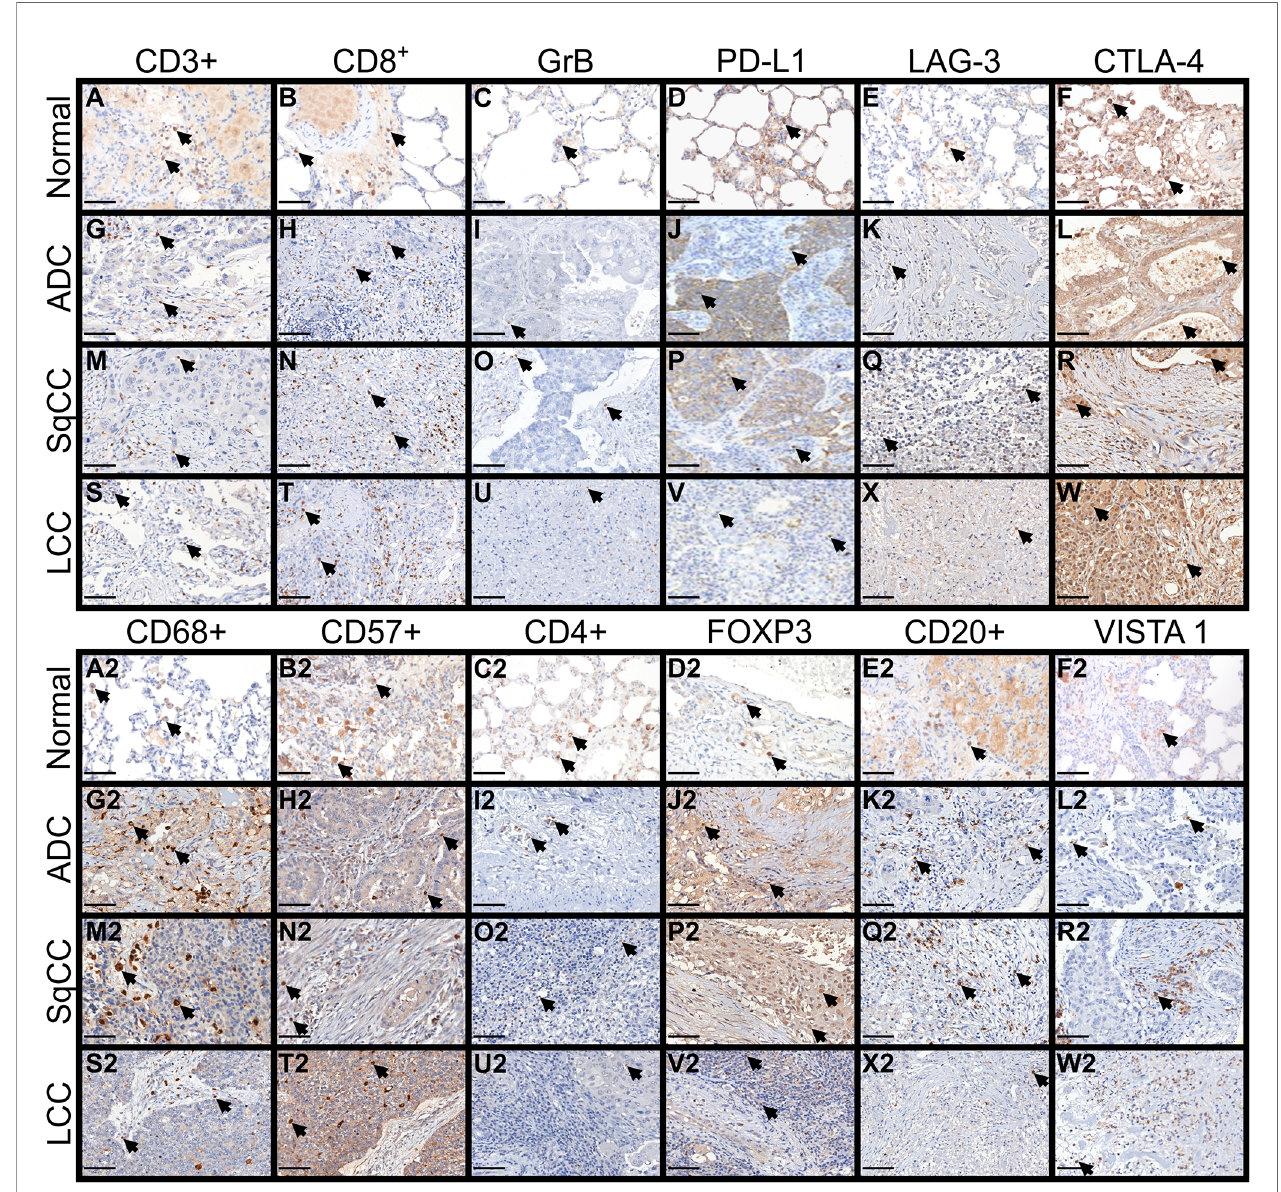
FIGURE 2 | Microphotographs of representative examples of the 12 immune markers in lung ADC, SqCC, and LCC specimens, divided into three compartments: normal tissue (A – F, A2 – F2) , tumor tissue, and intermediate tissue (G – W, G2 – W2) . Arrows indicate cells expressing each immune marker (brown). (A – F, A2 – F2) In control tissue, focal TLIs along of the alveolar septa are visible expressing the immune markers. (G – W) In tumor tissue, note the moderately expression of CD3+, CD8 + , PD-L1, LAG-3 and CTLA-4+ by tumor and stromal TILs of ADC, SqCC, and LCC. (G2 – W2) inferior panel showing a strong expression of CD68+, CD57+ and FOXP3+, and a moderate expression of CD20+ and VISTA 1. (C, I, O, U) No notable staining for Granzyme B was observed in TILs of the control and tumor tissue. ADC, adenocarcinoma; LCC, large cell carcinoma; SqCC, squamous cell carcinoma; GrB, Granzyme B; PD-L1, programmed death ligand 1; LAG-3, lymphocyte activating gene 3; CTLA-4+, Cytotoxic T-Lymphocyte Associated Protein 4; FOXP3+, Fork head box protein P3; VISTA 1, V-domain Ig suppressor of T cell activation. Scale bars: X400, 50